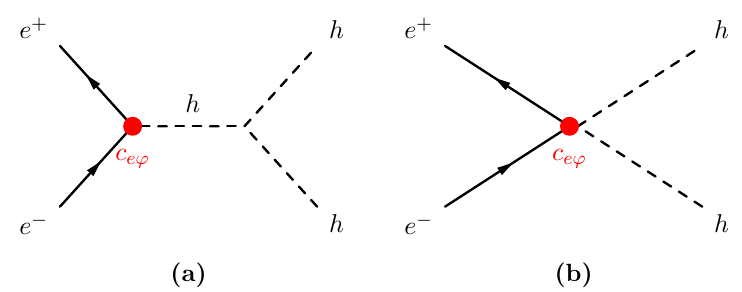
Figure 5. Tree level contribution to e + e (cid:0) ! hh coming from eq. (3.2).